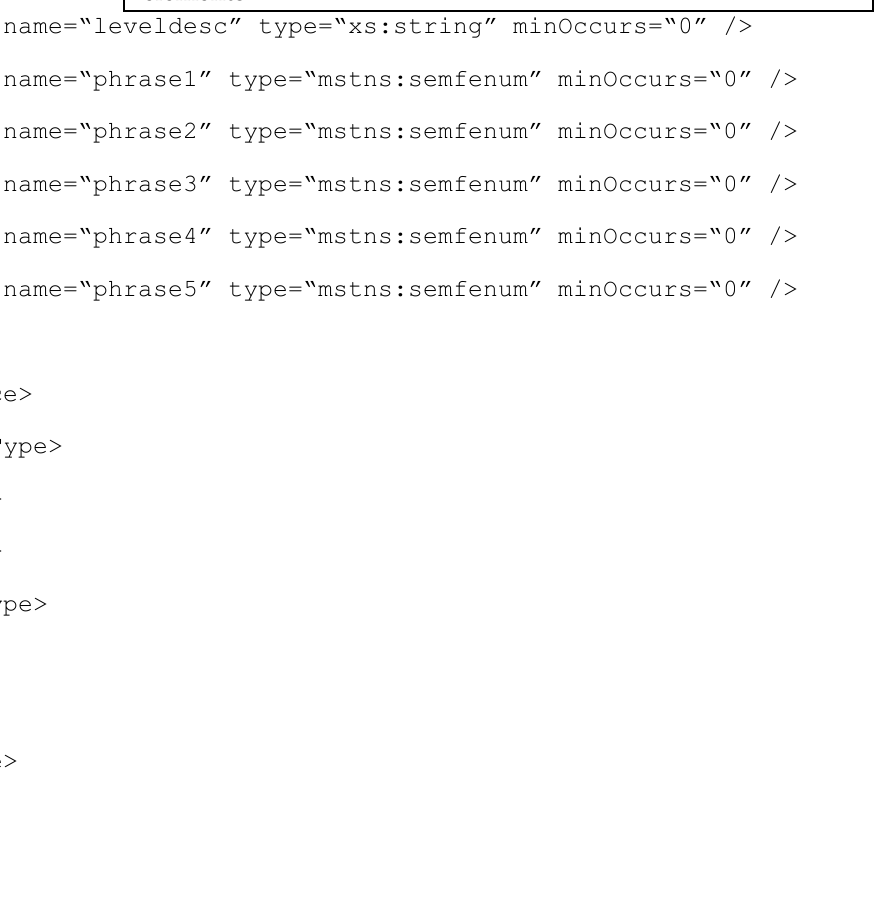
Using simple type semfenum to validate semantic function